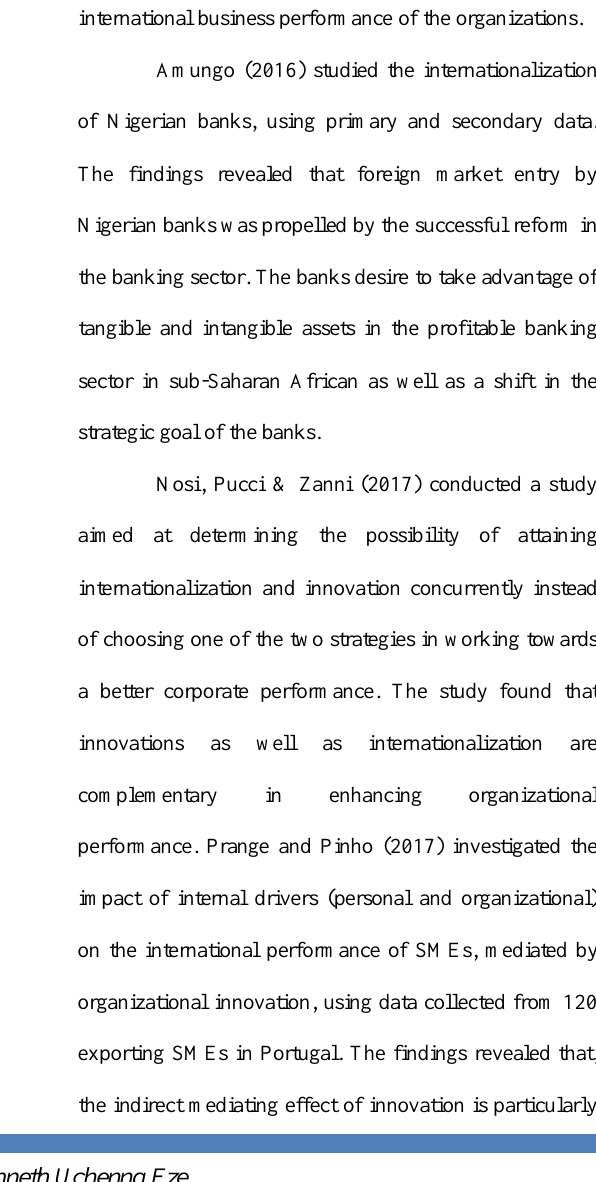
Figure 1. Conceptual